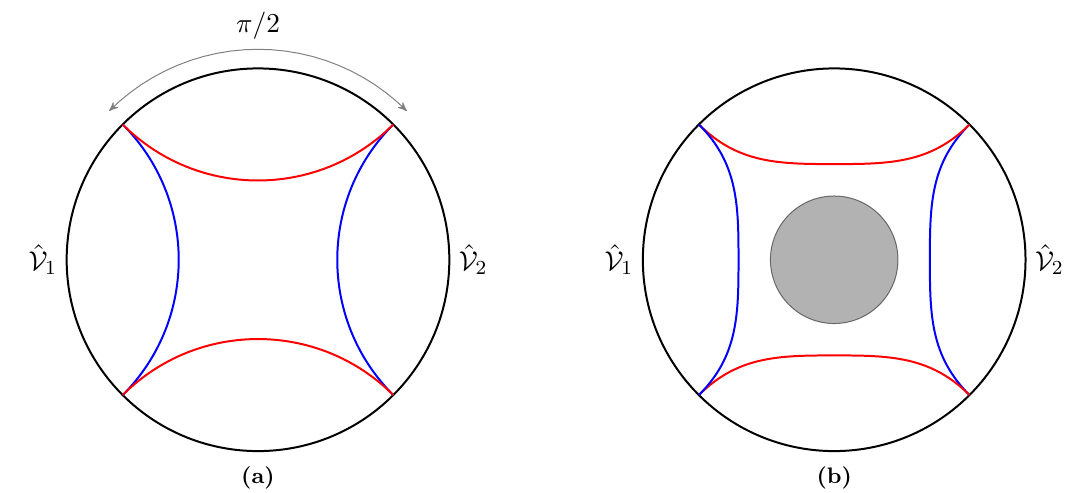
Figure 3. A counterexample to the converse of theorem 4. (a) Vacuum AdS 2+1 with regions ˆ ˆ V 1 and V 2 chosen antipodally and to each occupy π/ 2 of the boundary. Choosing the maximal consistent input and output regions, the entanglement scattering region is exactly one point, and the Ryu-Takayanagi surface is on the transition from disconnected (blue) to connected (red). (b) Spherically symmetric matter is added to the bulk. Now the entanglement wedges of ˆ V less deeply into the bulk [12], and the light rays sent inward normally from their extremal surfaces are delayed. This closes the entanglement scattering region. By spherical symmetry however the Ryu-Takayanagi surface remains on the transition. Deforming ˆ V connected phase, and for small enough deformation ensures the scattering region remains empty.